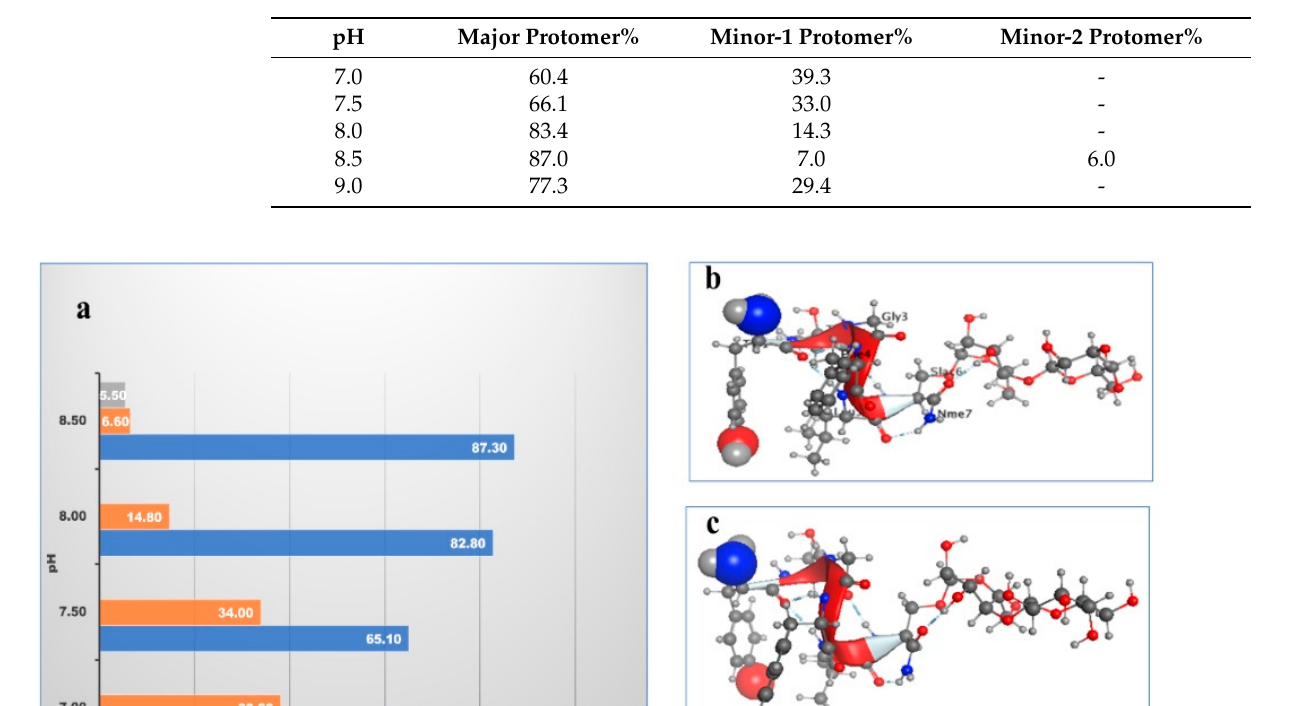
Table 6. Protomers population% of Lactomorphin at various pHs as calculated by MOE.